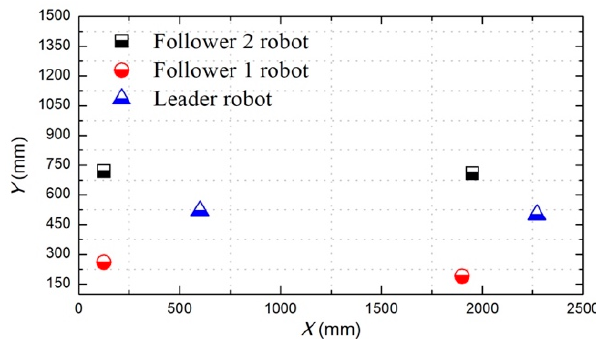
Figure 21. Calibration of the start and terminal coordinate (lateral queue).